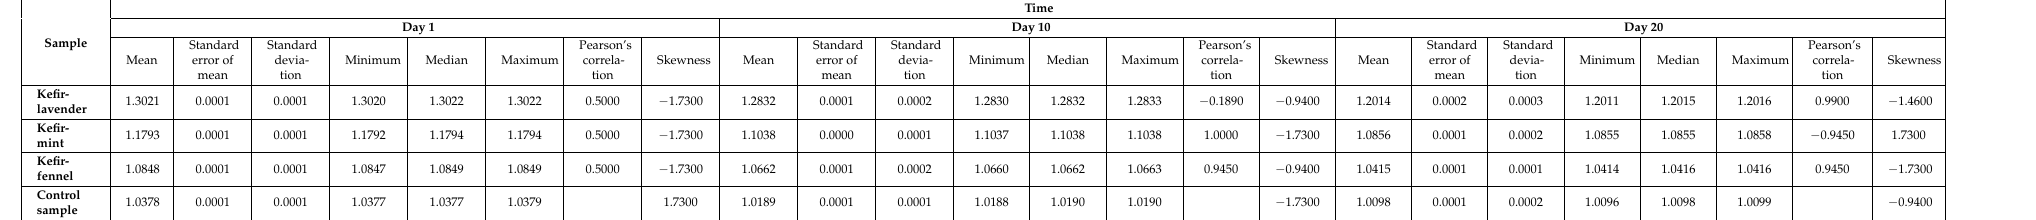
Table A2. Determination of D-galactose content.